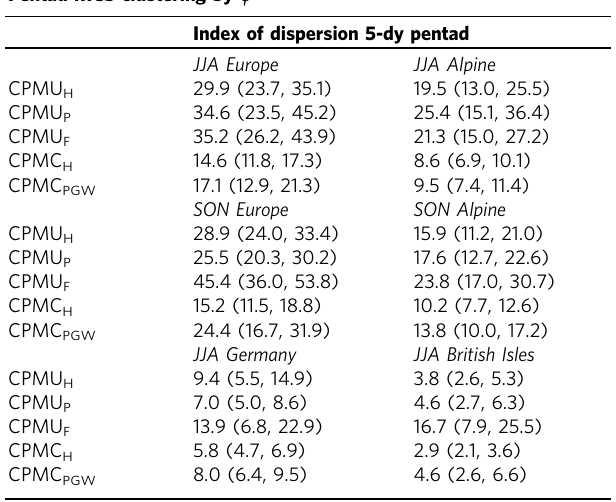
Table 2 The pentad index of dispersion (dimensionless, ^ ϕ ) for the number of